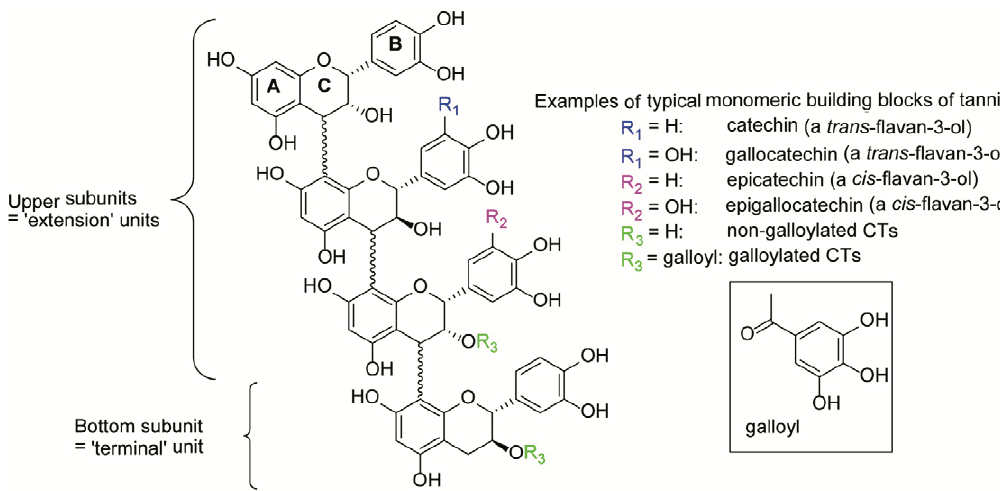
Figure 1. Condensed tannin molecule consisting of four flavan-3-ol monomers. Reproduced with permission from Mueller-Harvey et al. [84], Crop Science; published by John Wiley & Sons, 2019.